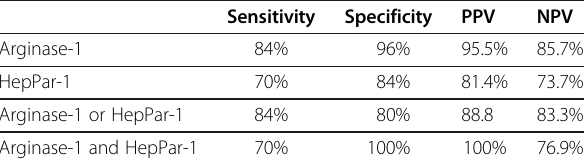
Table 4 Sensitivity, specificity, positive and negative predictive value of arginase-1, HepPar-1 for HCC